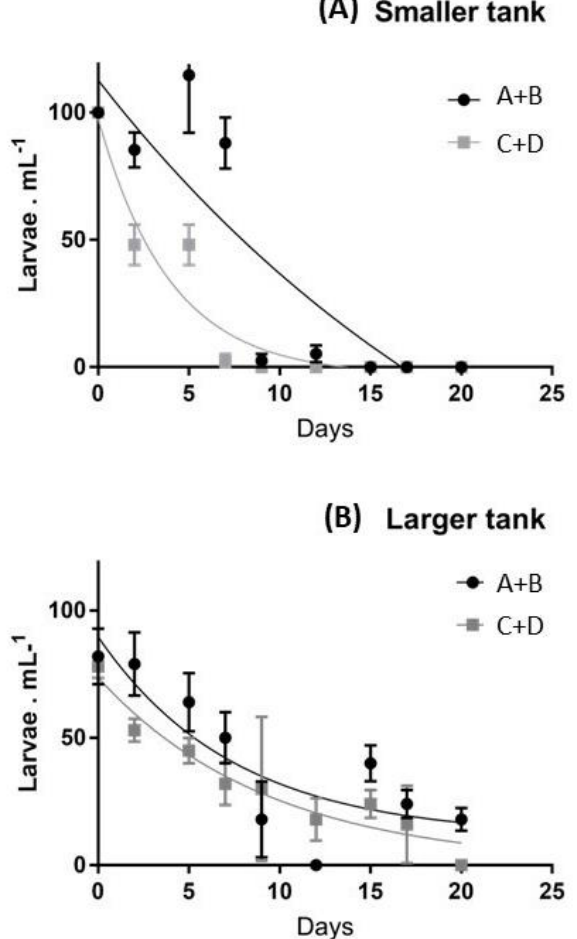
Figure 1. Average survival rates of larvae obtained from the two pools of individuals (A+B vs. C+D) in smaller ( A ) and larger ( B ) tanks.